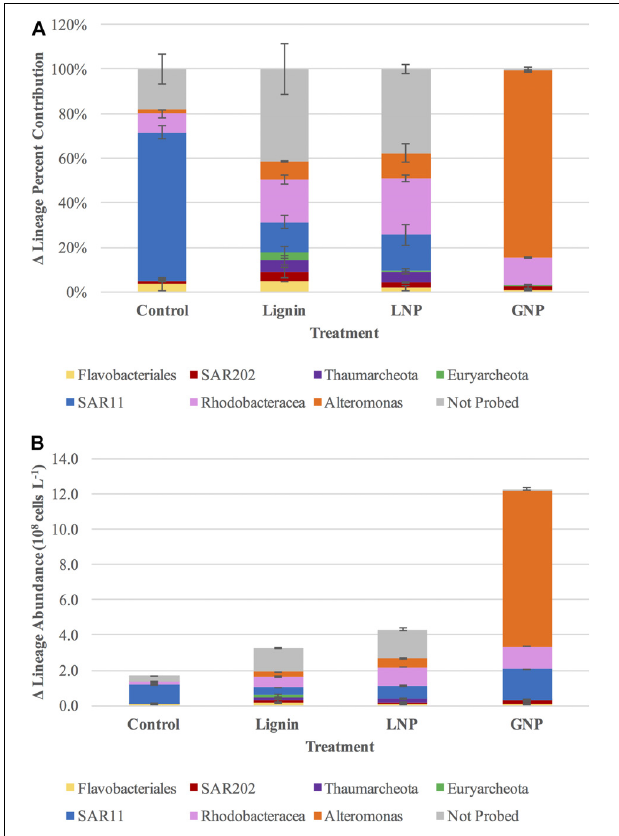
FIGURE 5 | (A) difference in percent contribution of specific lineages to the total prokaryote populations and (B) difference in the cell abundance of targeted lineages in each of the four treatments (Control, GNP, Lignin, LNP) between days 0 and 6 ( T 0 and T 10